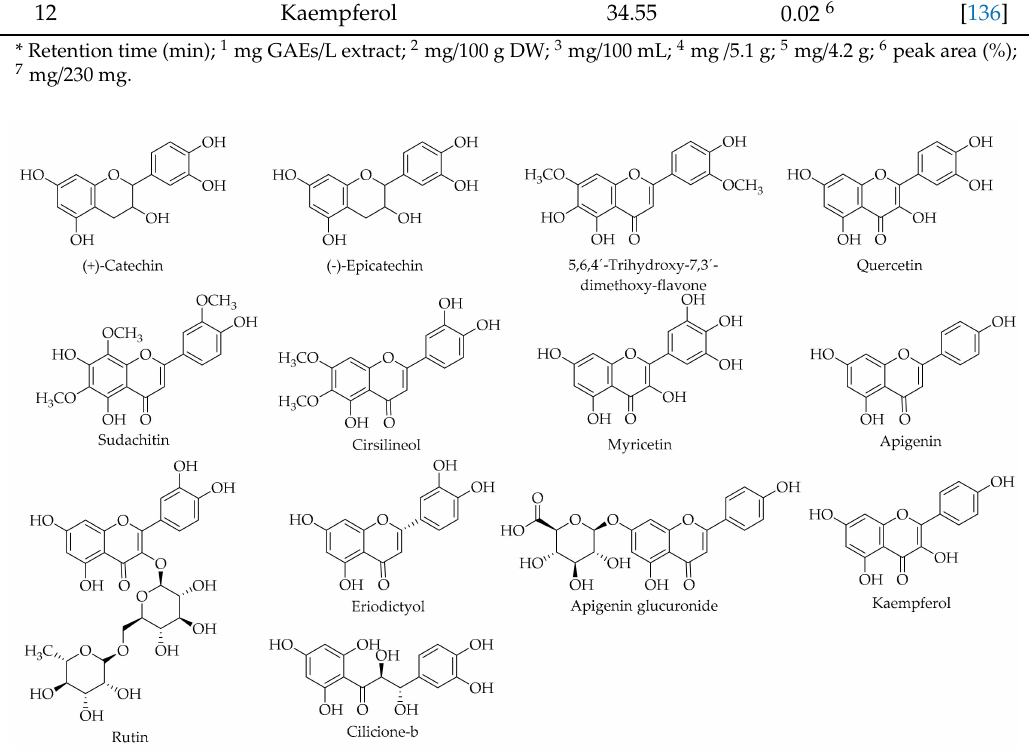
Figure 10. The chemical structures of di ff erent identified, isolated, and quantified flavonoids in the green husk of